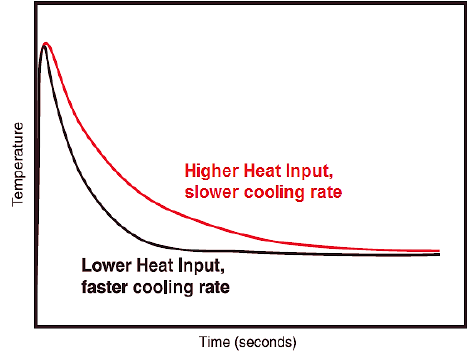
Figure 1. Heat input influences cooling rate [32].